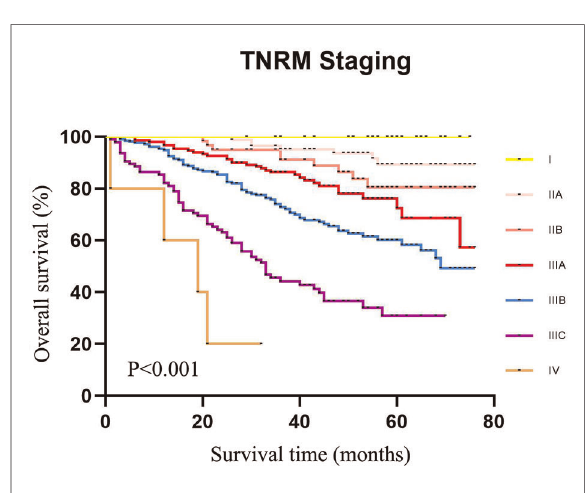
FIGURE 6 The 5-year survival rate of CRC patients in the validation set using our cases of CRC according to TNRM